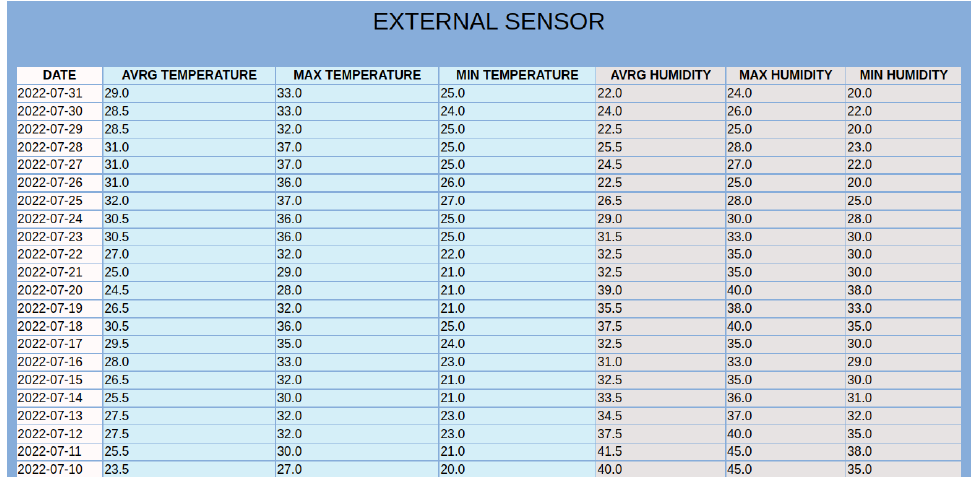
Figure 8. Statistical measures of temperature and humidity on a daily